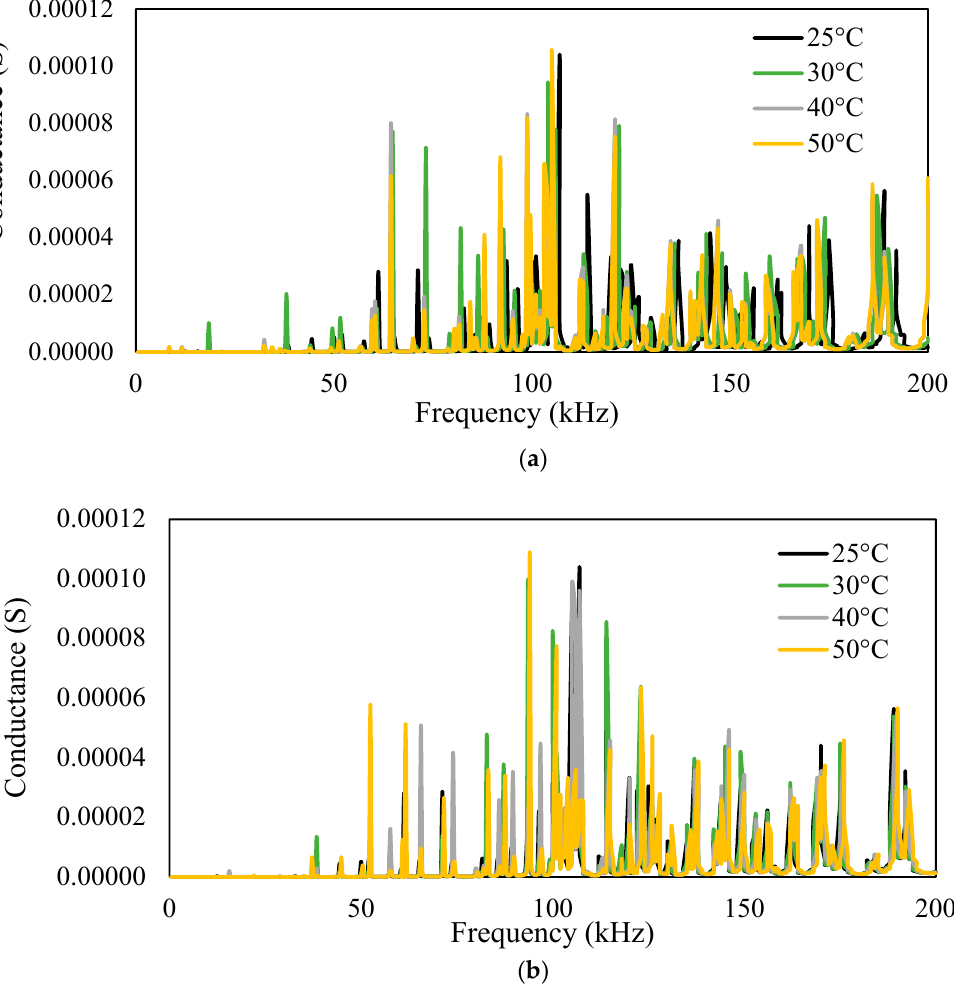
Figure 13. Conductance signature plot at different temperatures by varying the ( a ) modulus of elasticity and ( b ) density (of the aluminum block) + PZT patch.